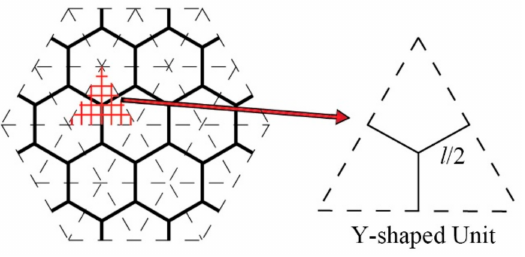
Figure 16. Y-shaped unit division of the hexagonal aluminum honeycomb structure.